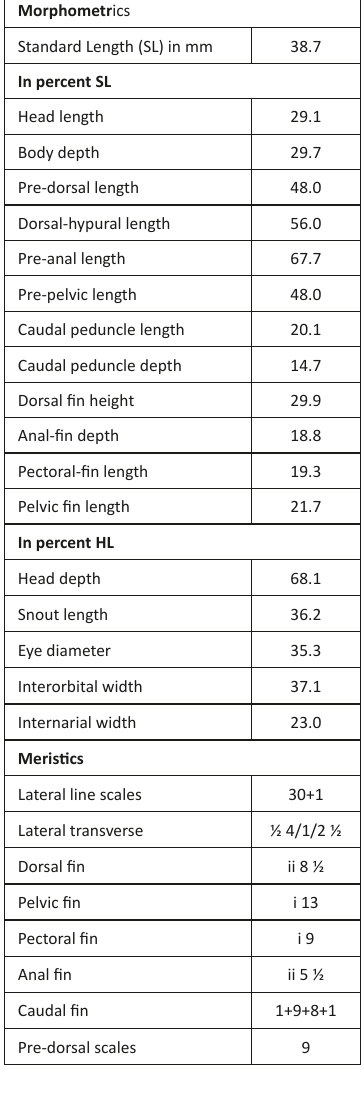
Table 1. Morphometric characters and meristics of Oreichthys andrewi sp. nov. (Holotype) ZSI/SRC F